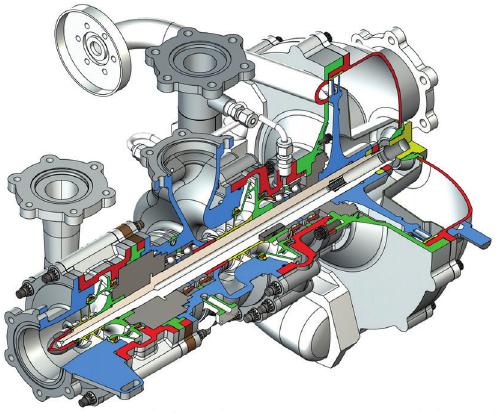
Figure 1. L75 rocket engine turbopump